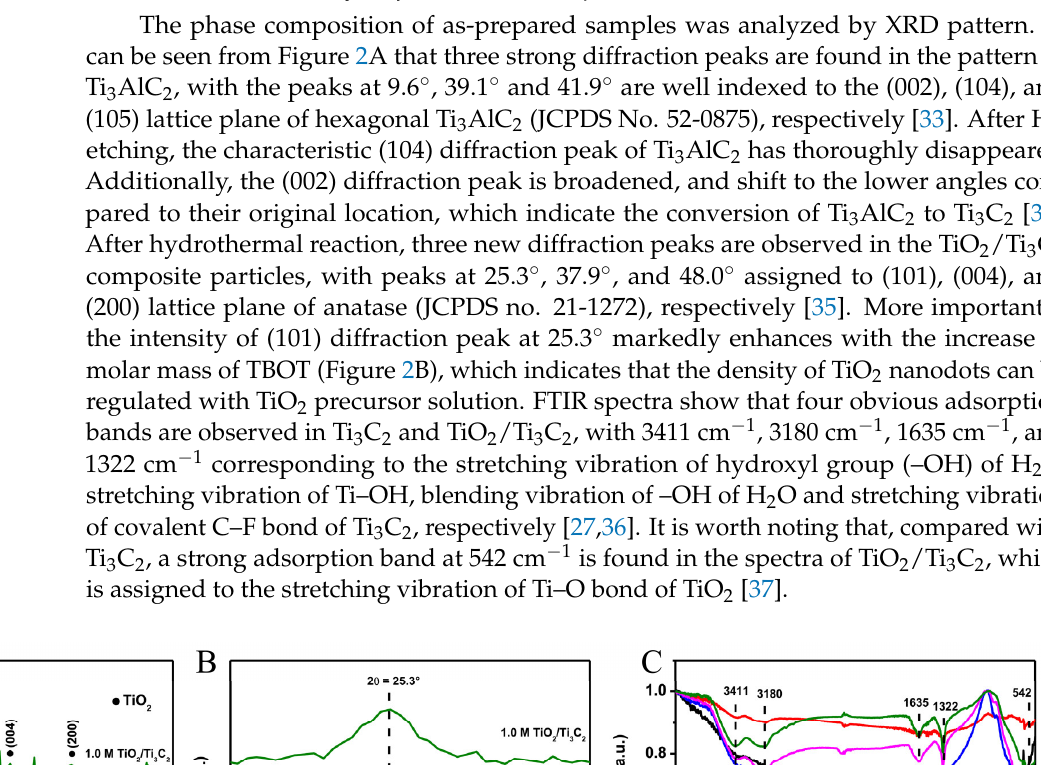
3 AlC 2 , Ti 3 C 2 , and TiO 2 /Ti 3 C 2